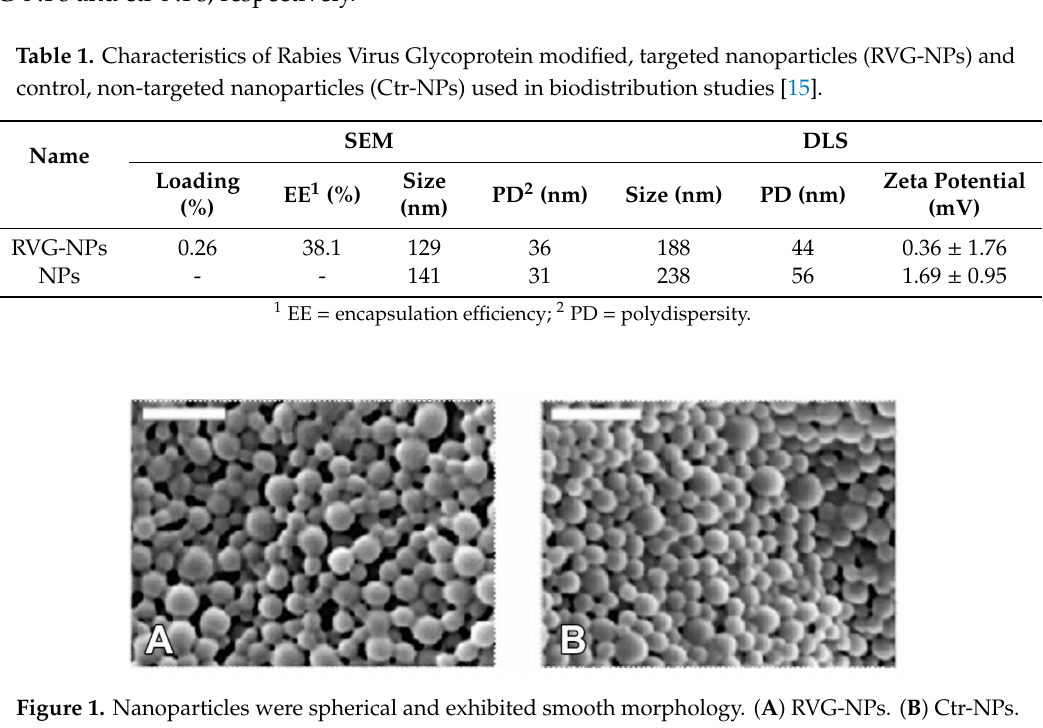
Figure 1. Nanoparticles were spherical and exhibited smooth morphology. ( A ) RVG-NPs. ( B ) Ctr-NPs. Scale bar =